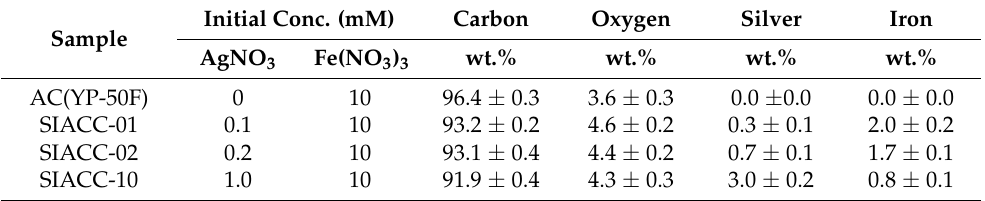
Table 1. Chemical composition of SIACCs using pristine AC prepared by